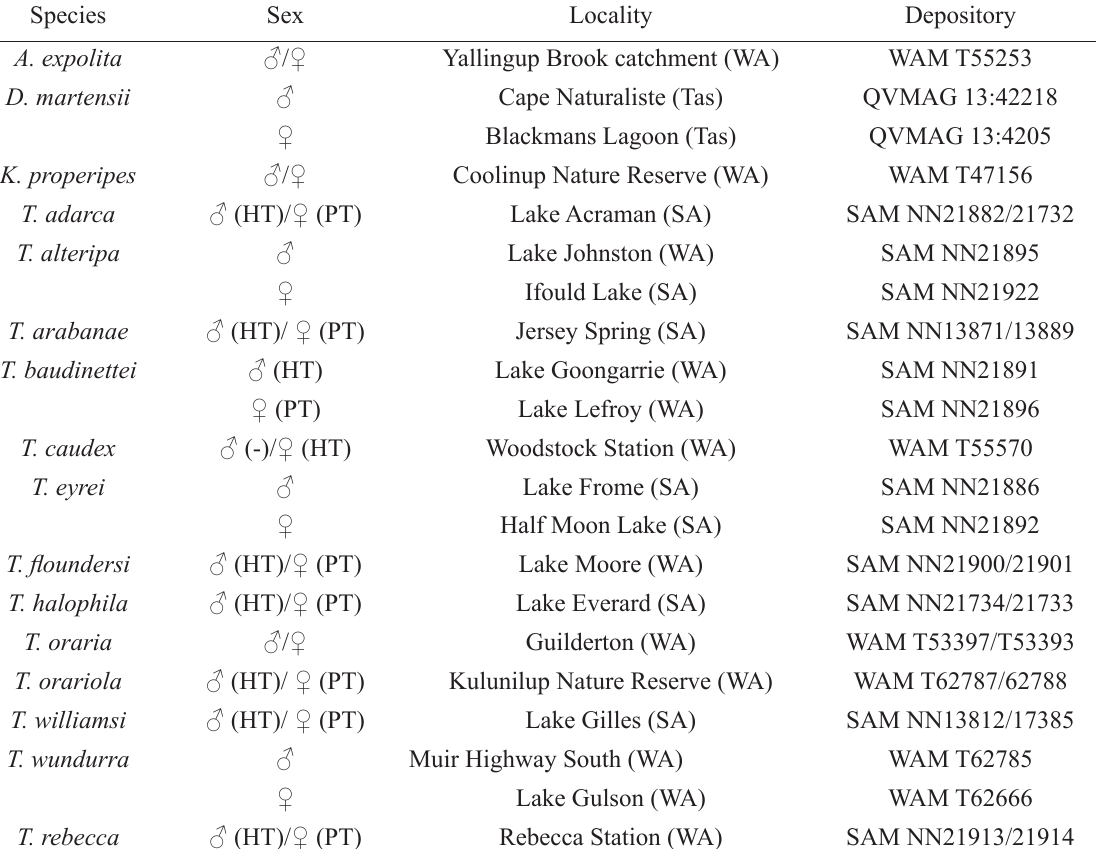
Table 3. Specimens used in phylogenetic analysis. Abbreviations: NSW = New South Wales; SA = South Australia; Tas = Tasmania; Vic = Victoria; WA = Western Australia; HT = holotype; PT = paratype.